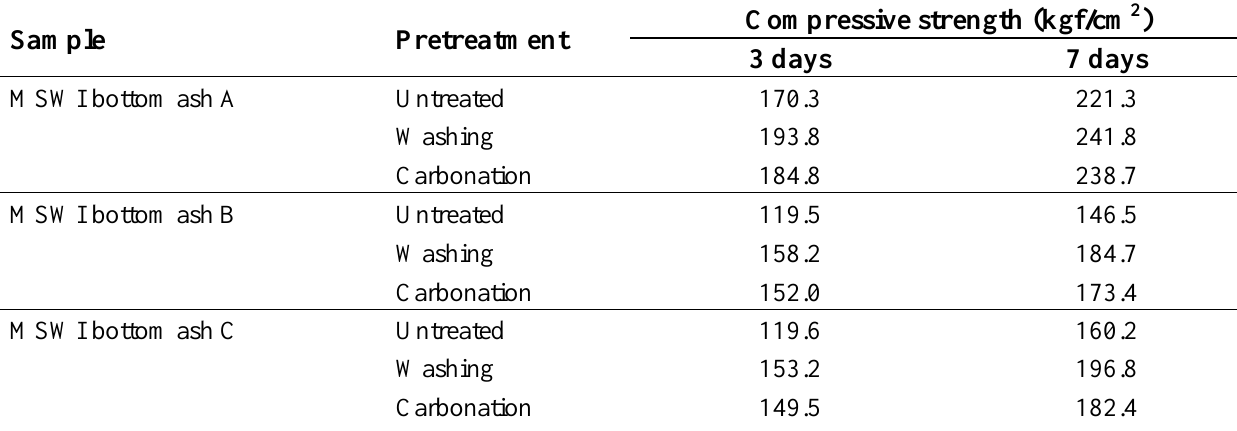
Table 3. Compressive strength of mortars (mixtures of the ash, Portland cement, and water) depending on pretreatments of the bottom ash from municipal solid waste incineration (MSWI) (modified from Ahn et al . [25] with permission of KSGE